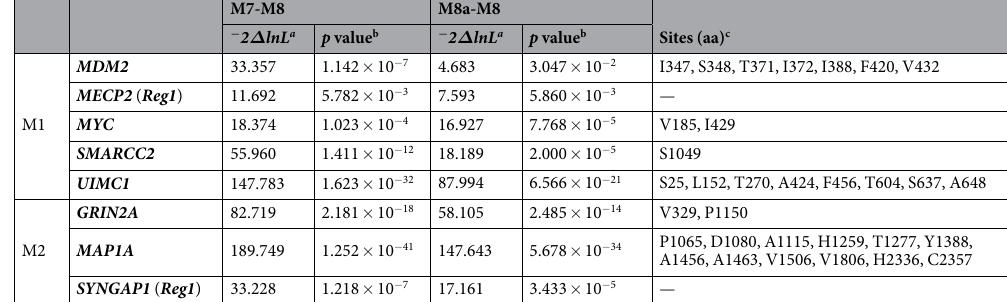
— Table 2. Likelihood ratio test (LRT) statistics for models of variable selective pressure among sites in the mammalian phylogeny (codon frequency: F3 × 4). Models: M7 is a null model that assumes that 0 < ω < 1 is beta distributed among sites; M8 (positive selection model) is the same as M7 but also includes an extra category of sites with ω > 1. M8a is the same as M8, except that the 11 th category cannot allow positive selection, but only neutral evolution. a 2 Δ lnL: twice the difference of the natural logs of the maximum likelihood of the models being compared. b p values are FDR corrected. c Positions refer to the human sequence (see Supplementary Table 1, Supplementary